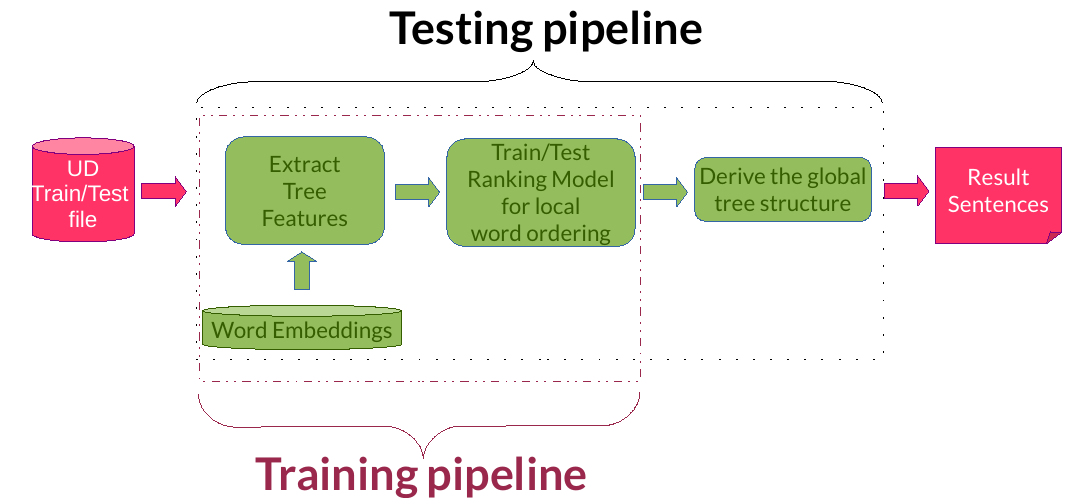
Figure 4. The training and testing pipelines.